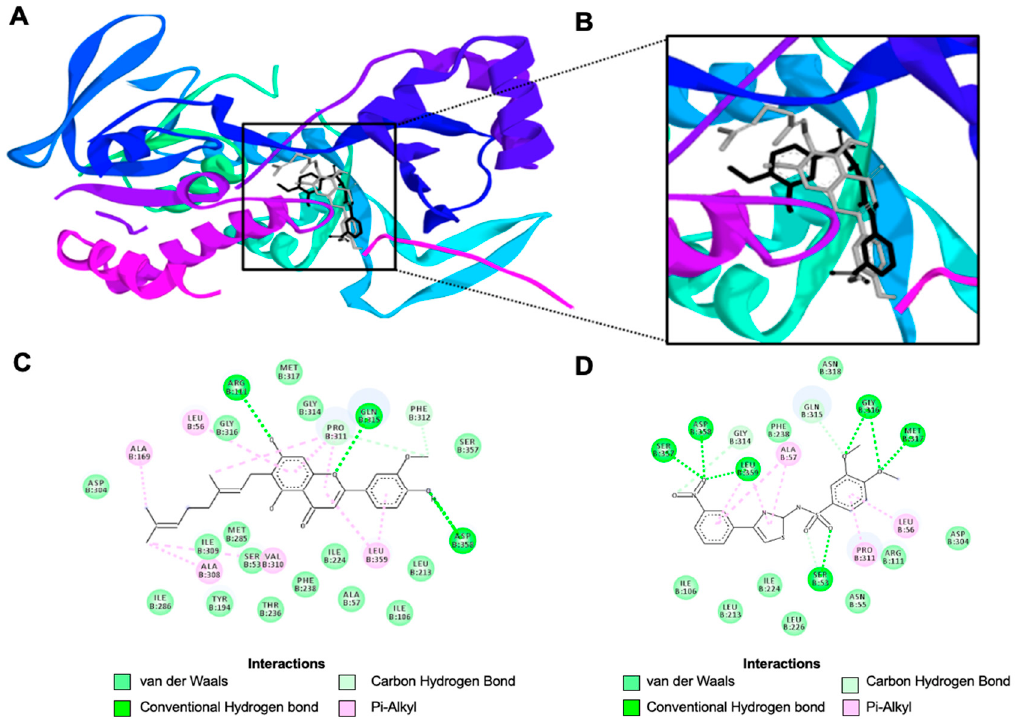
Figure 4. Molecular docking interactions of CFA and Ro 61-8048 with KMO. ( A ) Visualization of the docking site between CFA and Ro 61-8048 on the KMO protein. ( B ) Enlarged depiction of the ligand docking site on KMO with CFA colored in gray and Ro 61-8048 colored in black. ( C ) Predicted two- dimensional binding interactions between CFA and KMO. ( D ) Predicted two-dimensional binding interactions between Ro 61-8048 and KMO.